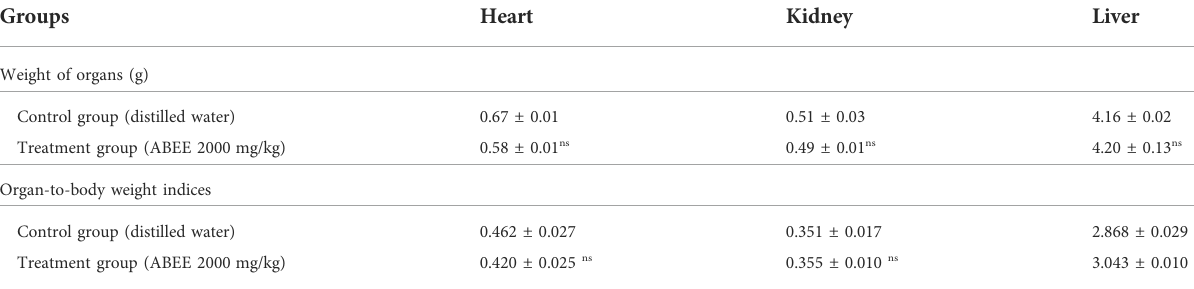
TABLE3Effect ofABEE(atlimitdose2000 mg/kgp.o.)andvehicletreatmentonweightoforgansandorgan-to-bodyweightindicesinacutetoxicity study.